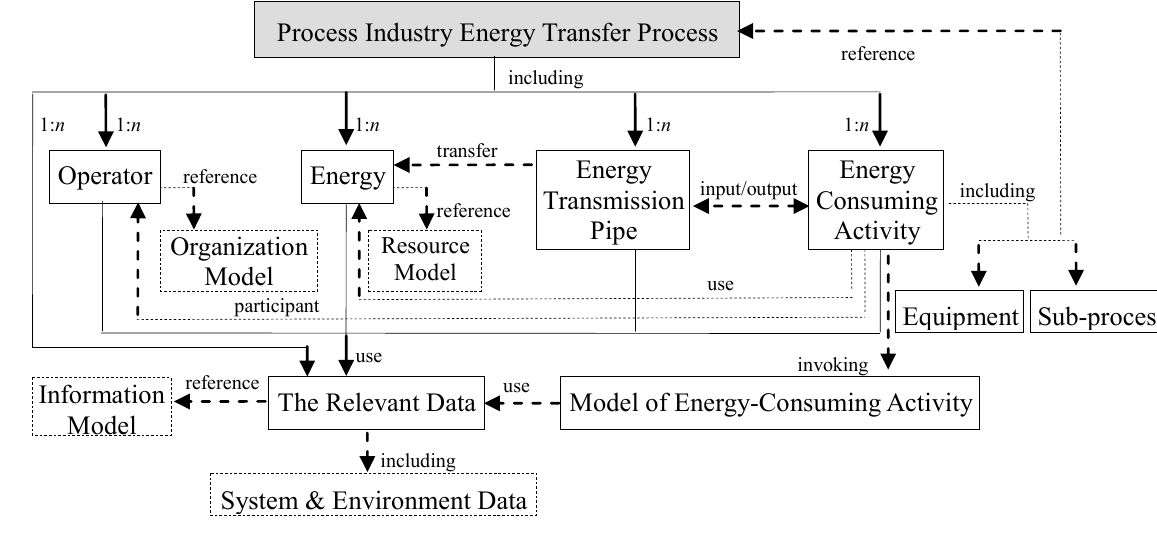
Figure 1. The key factors of process industry energy transfer